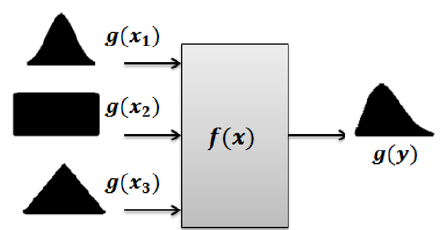
Figure 7. The process of the Monte Carlo methodology. x 1 , x 2 , and x 3 are input quantities, g(x 1 ), g(x 2 ), and g(x 3 ) are the distribution functions of the input quantities, and g(y) is the distribution function of the measurand.